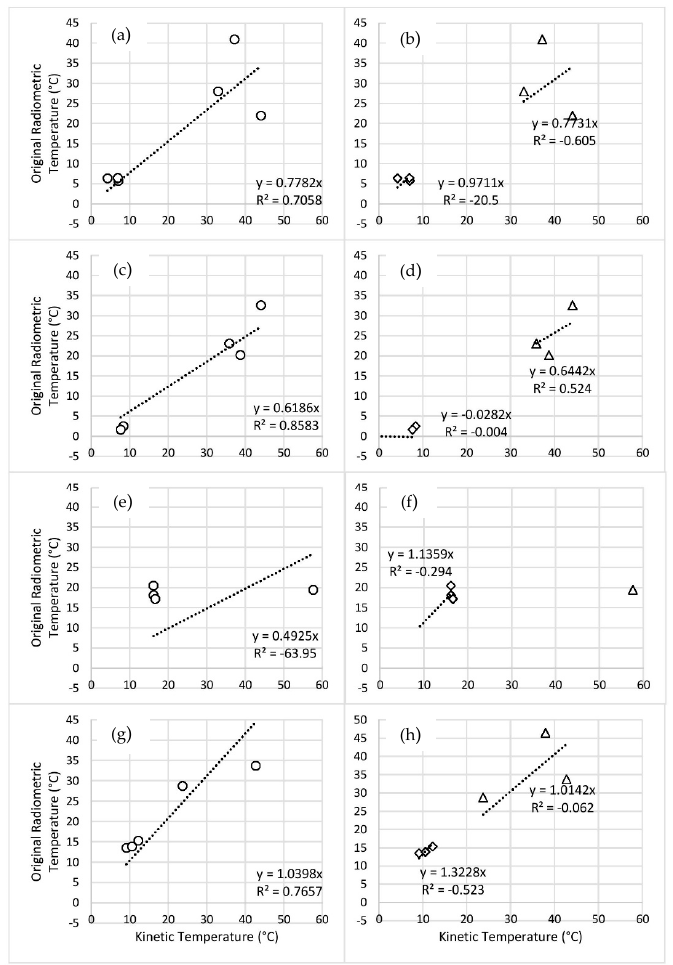
Figure A1. Pre-transformed radiometric temperature from TIR orthomosaics vs. kinetic temperature from TidbiTs. Left column ( a , c , e , g ) is combined data and right column ( b , d , f , h ) is data separated into geothermally influenced (triangles) and nongeothermally influenced (diamonds). From top to bottom are November 2018 ( a , b ), March 2019 ( c , d ), July 2019 ( e , f ) and September 2019 ( g , h ) survey data.